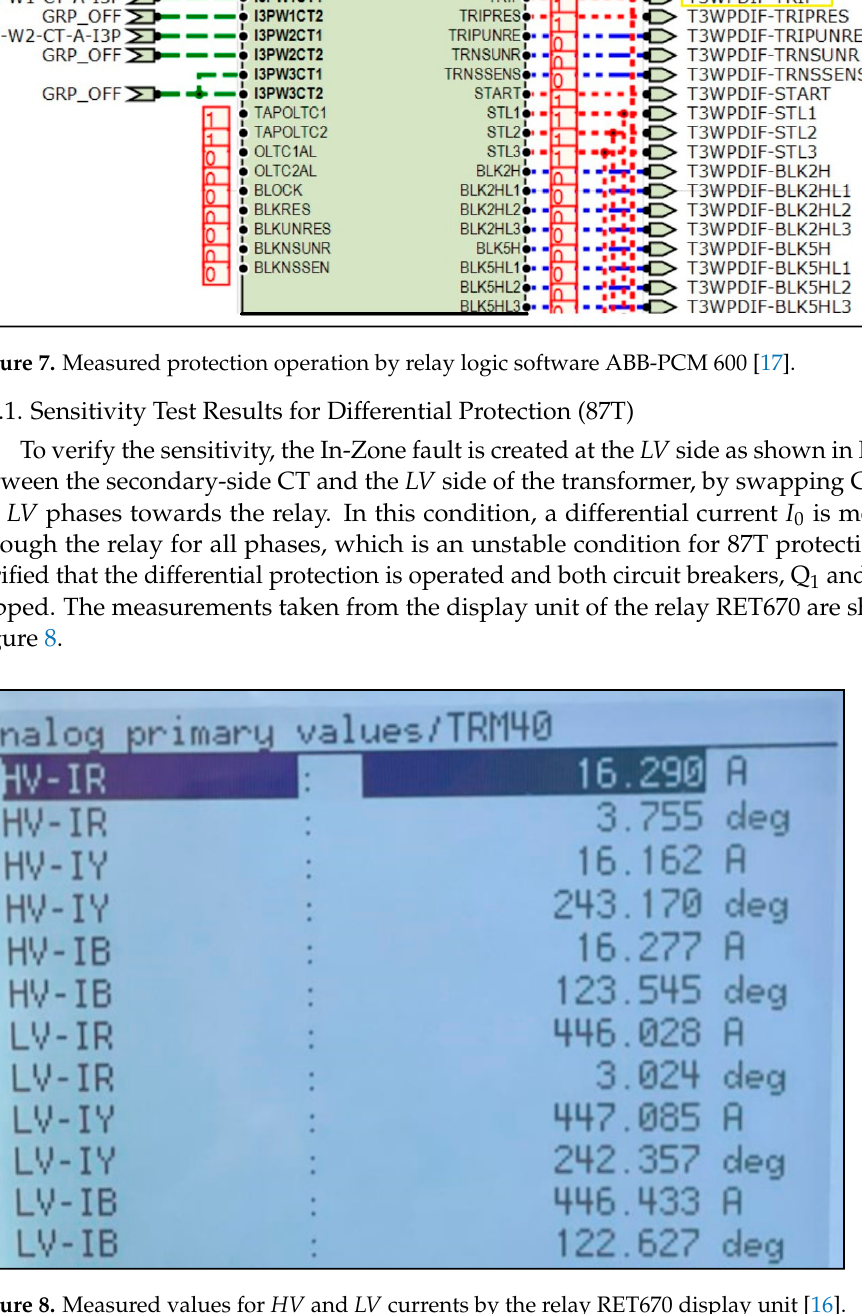
Figure 6. Measured values for differential ( I 0 ) and biased ( I b ) currents by the relay RET670 [16]. Here, IDL1MAG, IDL2MAG, and IDL3MAG are the values of differential currents